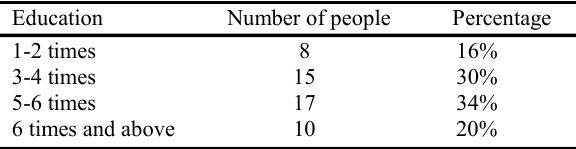
Table 3-3 Analysis of the number of times of participation of